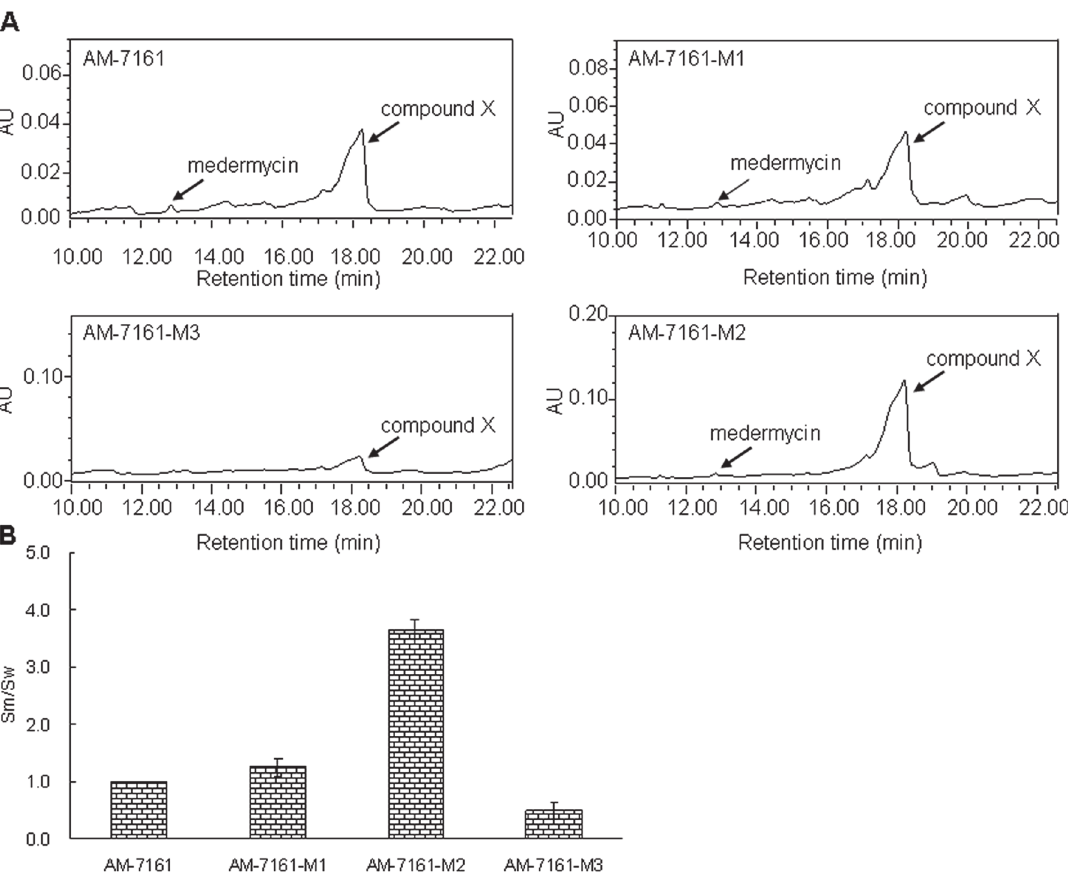
Fig 6. Metabolite analysis of AM-7161 and mutant strains by HPLC. (A) UV absorption at 254 nm of AM-7161 and mutant strains. (B) The ratio of the peak area (Sm) by mutant strains to the peak area (Sw) by AM-7161 at 18.2 min, indicating the production of compound X.